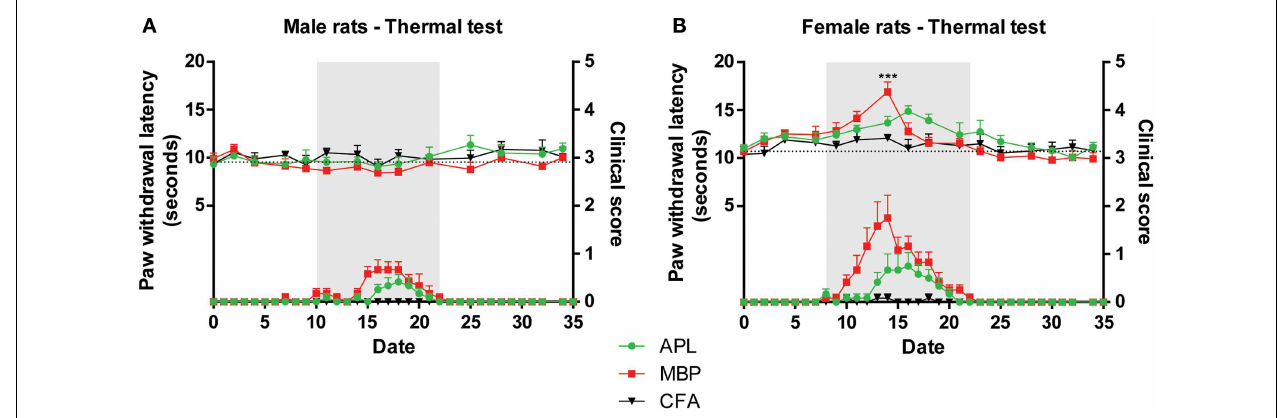
latency on day 14, with no other significant difference observed at any other time-points. ( n = 6 rats per group, *** p < 0.001, MBP compared to control; two-way ANOVA with Bonferroni’s post-tests; upper panel). Gray region indicates periods of established disease. Dotted line represents mean baseline values. Data expressed as mean ±